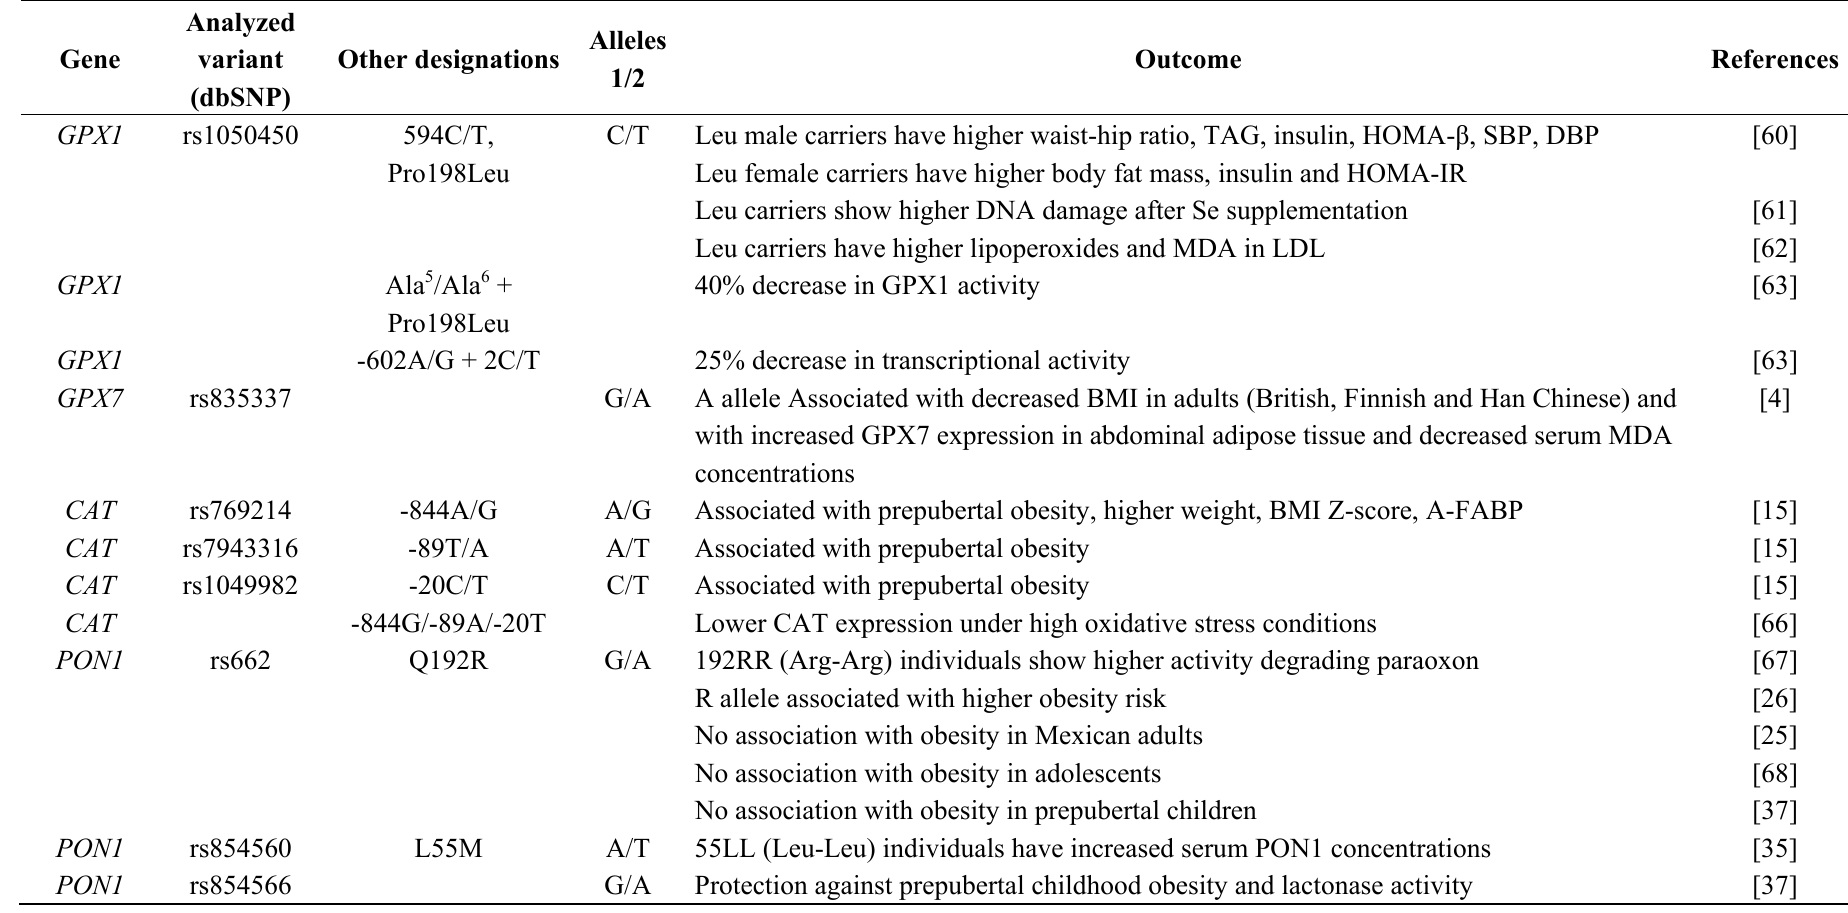
Table 2. Genetic variants in oxidative stress genes associated with obesity and related